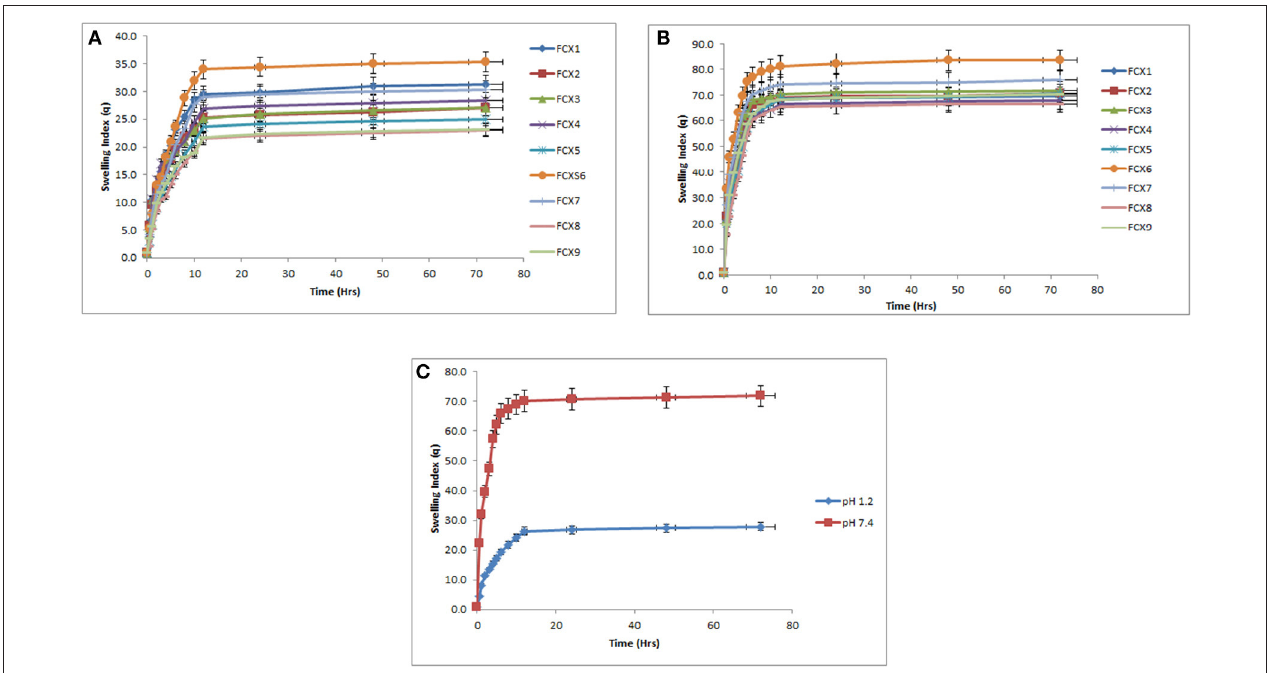
FIGURE 6 | Mean swelling index of hydrogels (FCX1 to FCX9) at pH 1.2 and pH 7.4. (A) Swelling index of hydrogels formulations FCX at pH 1.2. (B) Swelling index of hydrogels formulations at pH 7.4. (C) Mean swelling index of hydrogels (FCX1–FCX9) at pH 1.2 and pH 7.4.